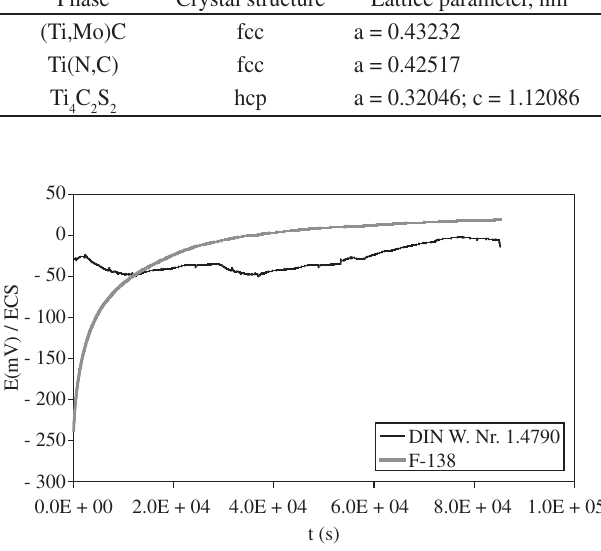
Figure 1. OCP variation for AISI 316L (ASTM F-138) and DIN W. Nr. 1.4970 SS in PBS solution at room